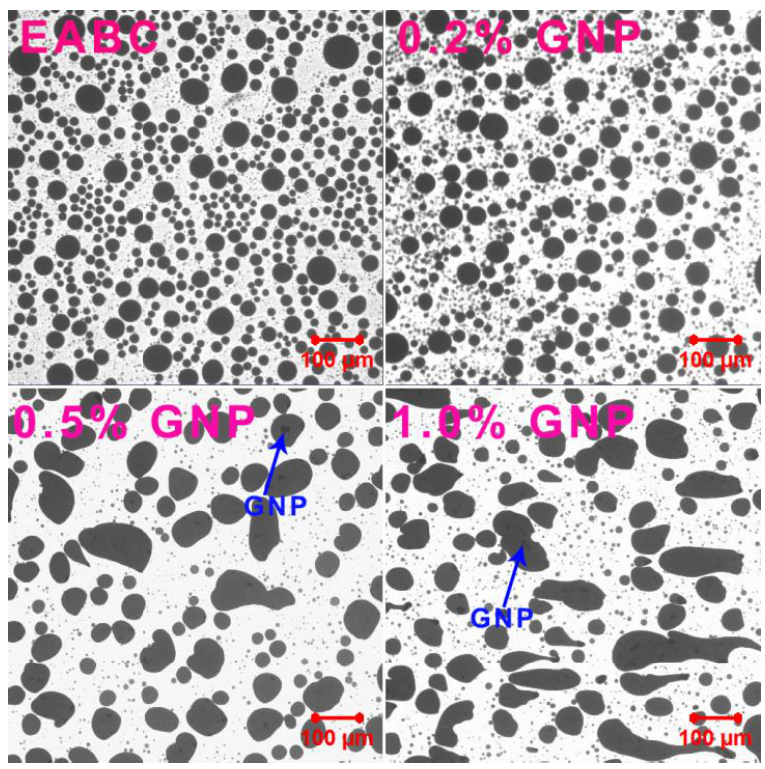
Figure 3. Transmittance confocal microscopy images of GNP-reinforced EABCs. Table 3. d n , d w and PDI s of the asphalt particles in GNP-reinforced EABCs.